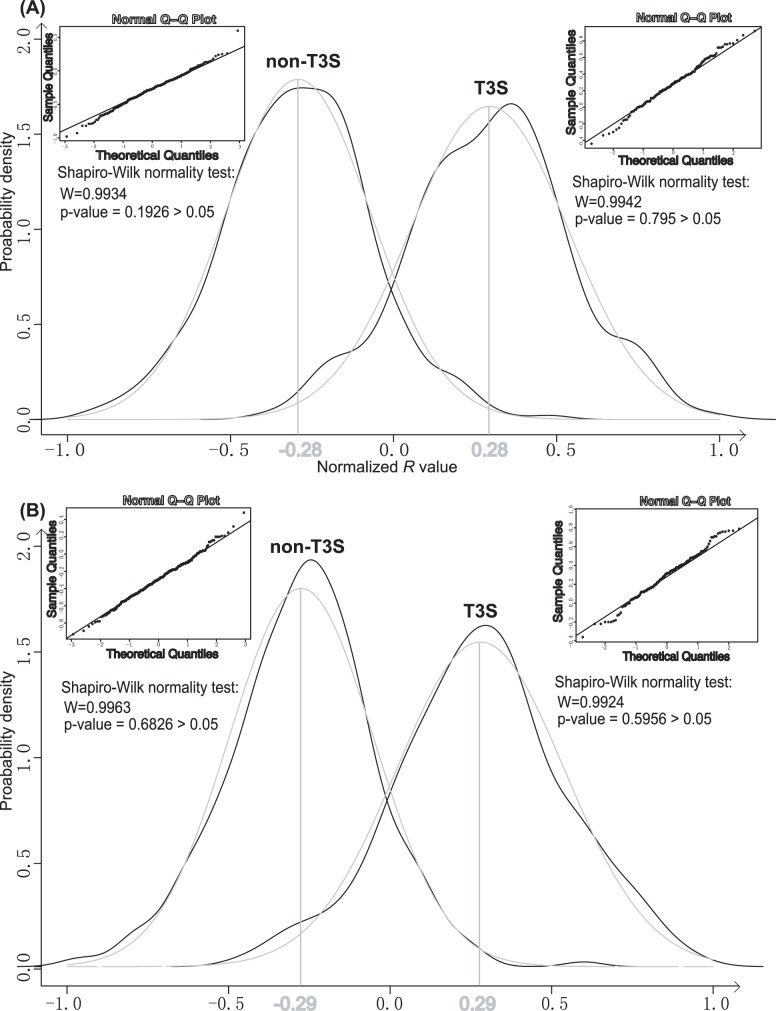
Probabilistically modelling the overall difference of conditional probability profiles of T3S and non-T3S sequences.The distribution (black curves) and normal approximations (grey curves) of T3S and non-T3S R values (A) and weighted R values (B) were shown. The means of approximated normal distributions were also indicated. For each normal approximation, the Normal Q–Q plot and Shapiro-Wilk normality test results were shown nearby corresponding distribution curve.